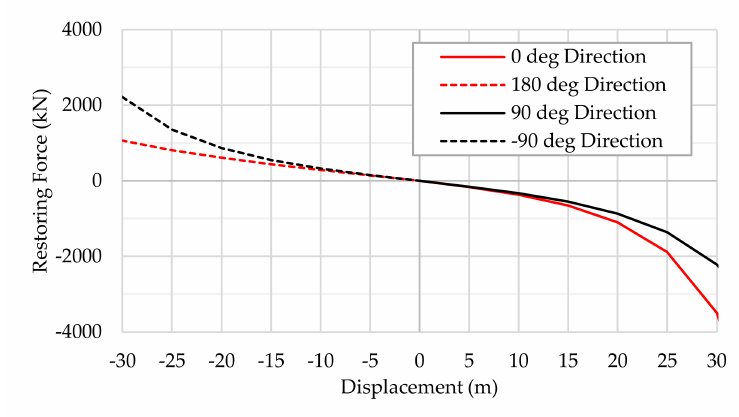
Figure 5. Mooring buoy restoring force curves in surge and sway